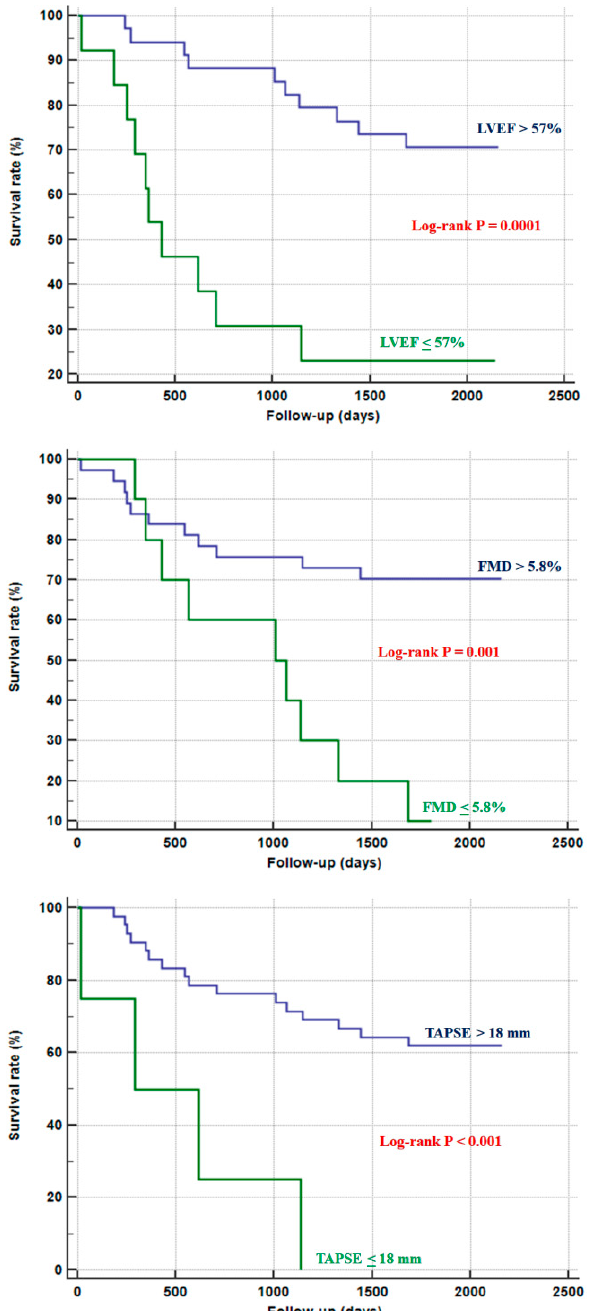
Figure 1. Survival curves for all-cause mortality according to the vascular and echocardiographic pa- rameters dichotomized by their optimal cut-off. FMD: flow-mediated vasodilatation of the branchial artery; LVEF: left ventricle ejection fraction; TAPSE: tricuspid annular plane systolic excursion. ROC curve analysis was used in order to identify the cut-offs of the echocardiographic and vascular parameters that were able to predict mortality. Table 3 gathers the main findings from the analysis, where the baseline LVEF ≤ 57% and baseline FMD value ≤ 5.8% represent the significant cut-offs retrieved from the